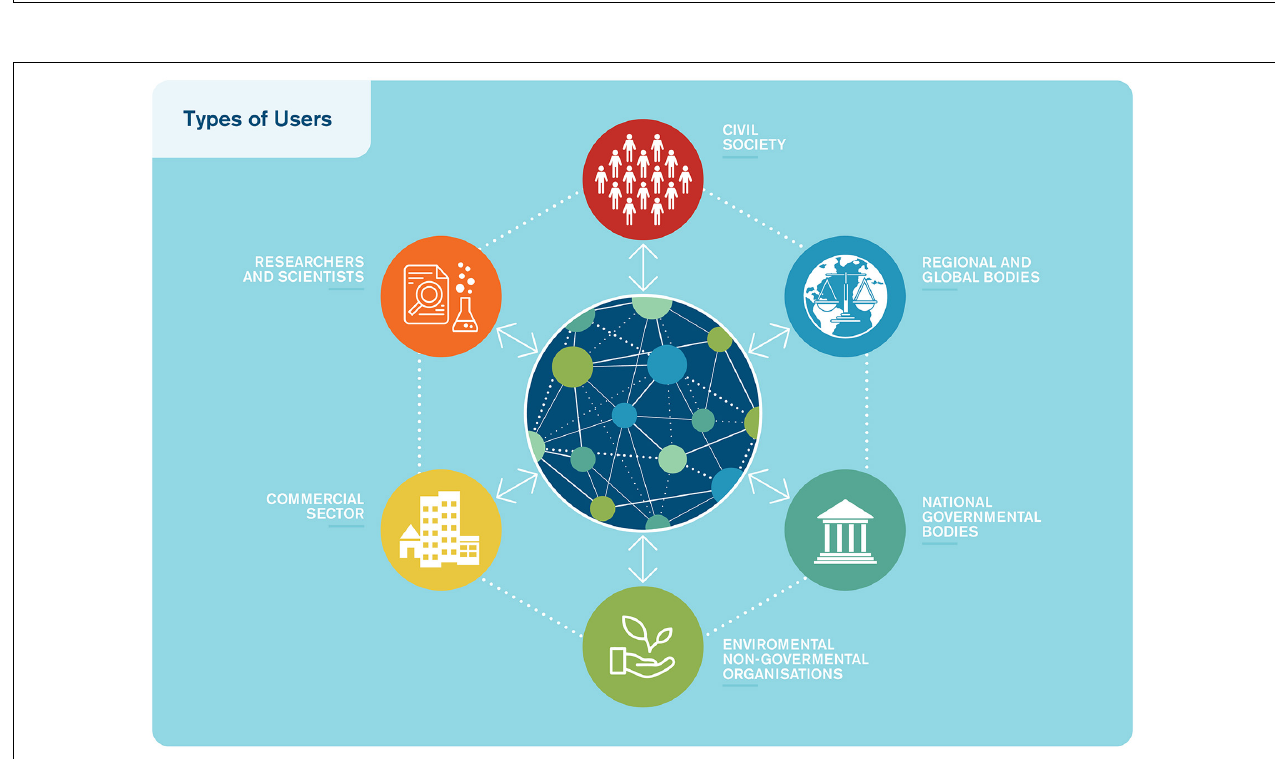
FIGURE 2 | Types of users. The data and data products provided by AtlantOS will support many user groups, ranging from industry to private citizens, from government to non-governmental organizations.